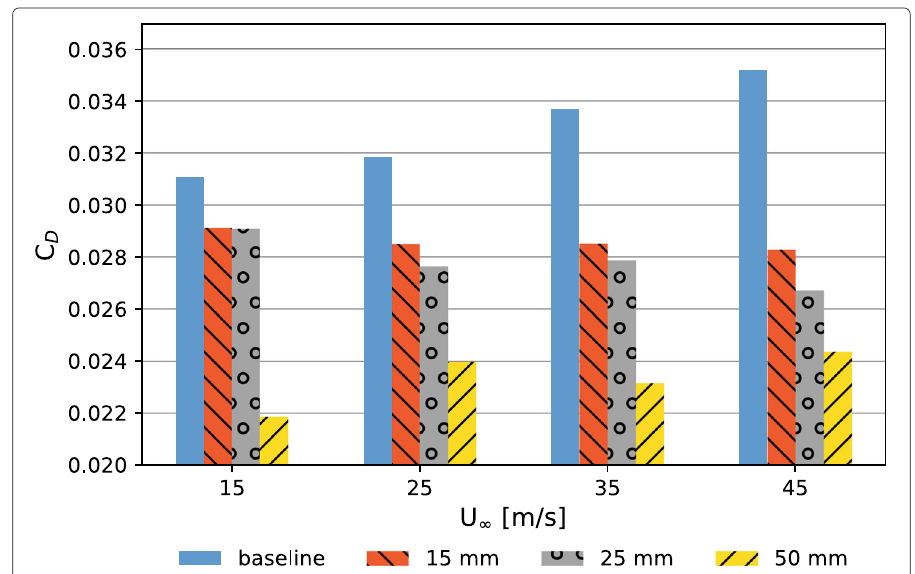
Fig. 10 Time-averaged drag coefficient for the front wheels only with conventional wheel deflectors